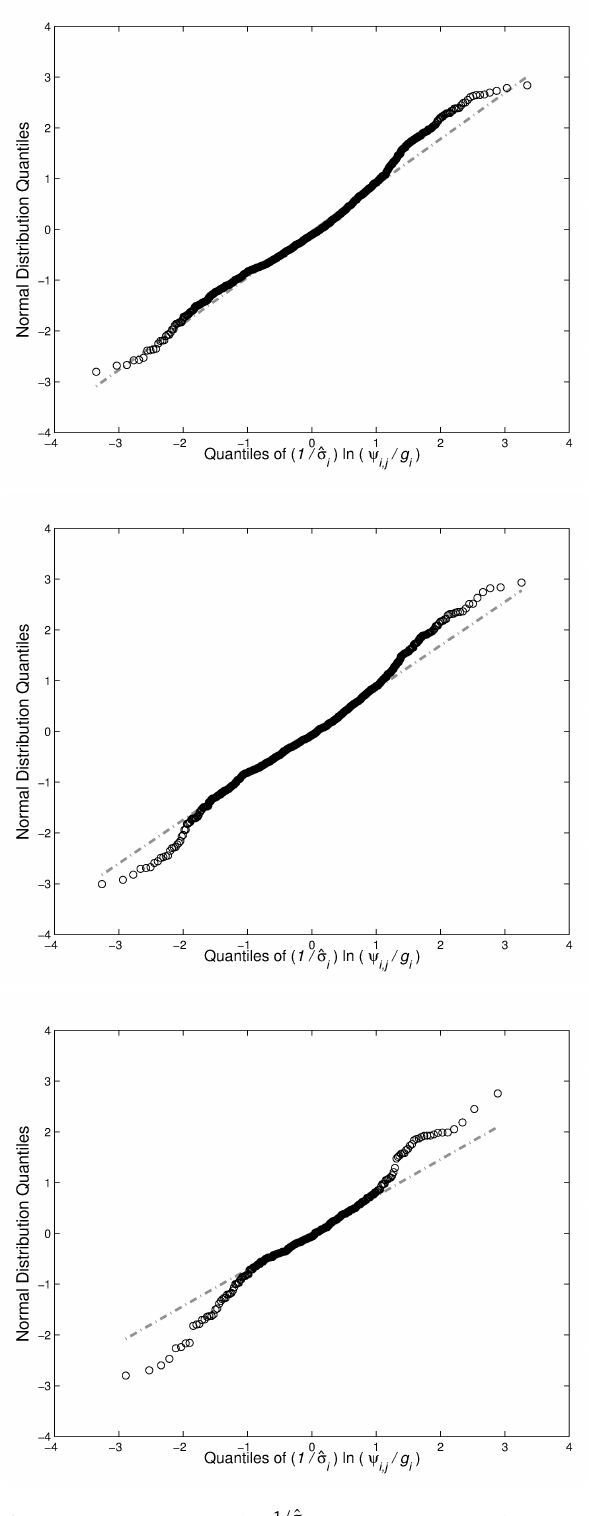
Fig. 5. QQ plot of ln ((ψ i,j /g i ) 1 / ˆ σ i ) , the rescaled runoff / loss ratios in Fig. 4 after a